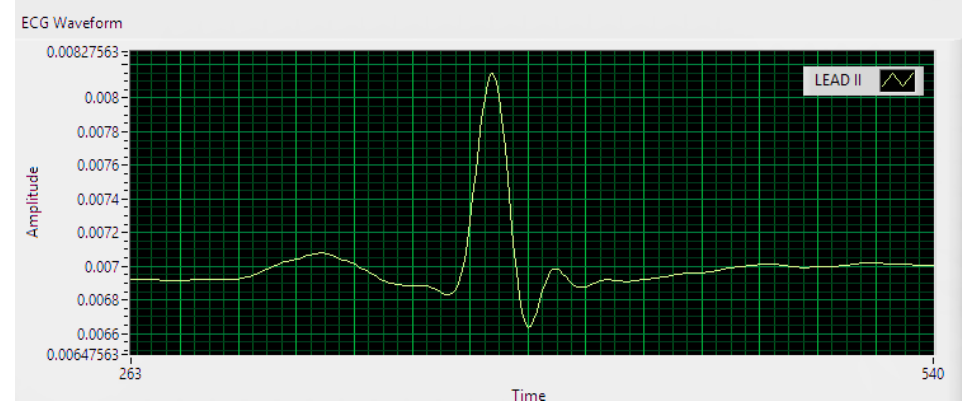
Figure 15. ECG signal acquired.